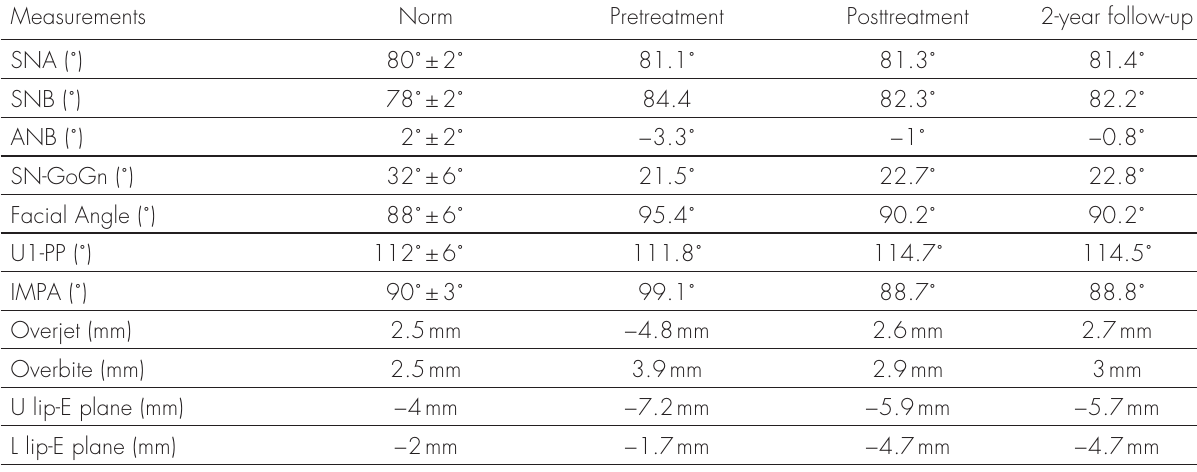
Table I. Cephalometric measurements at the pretreatment, posttreatment and follow-up with norm values.